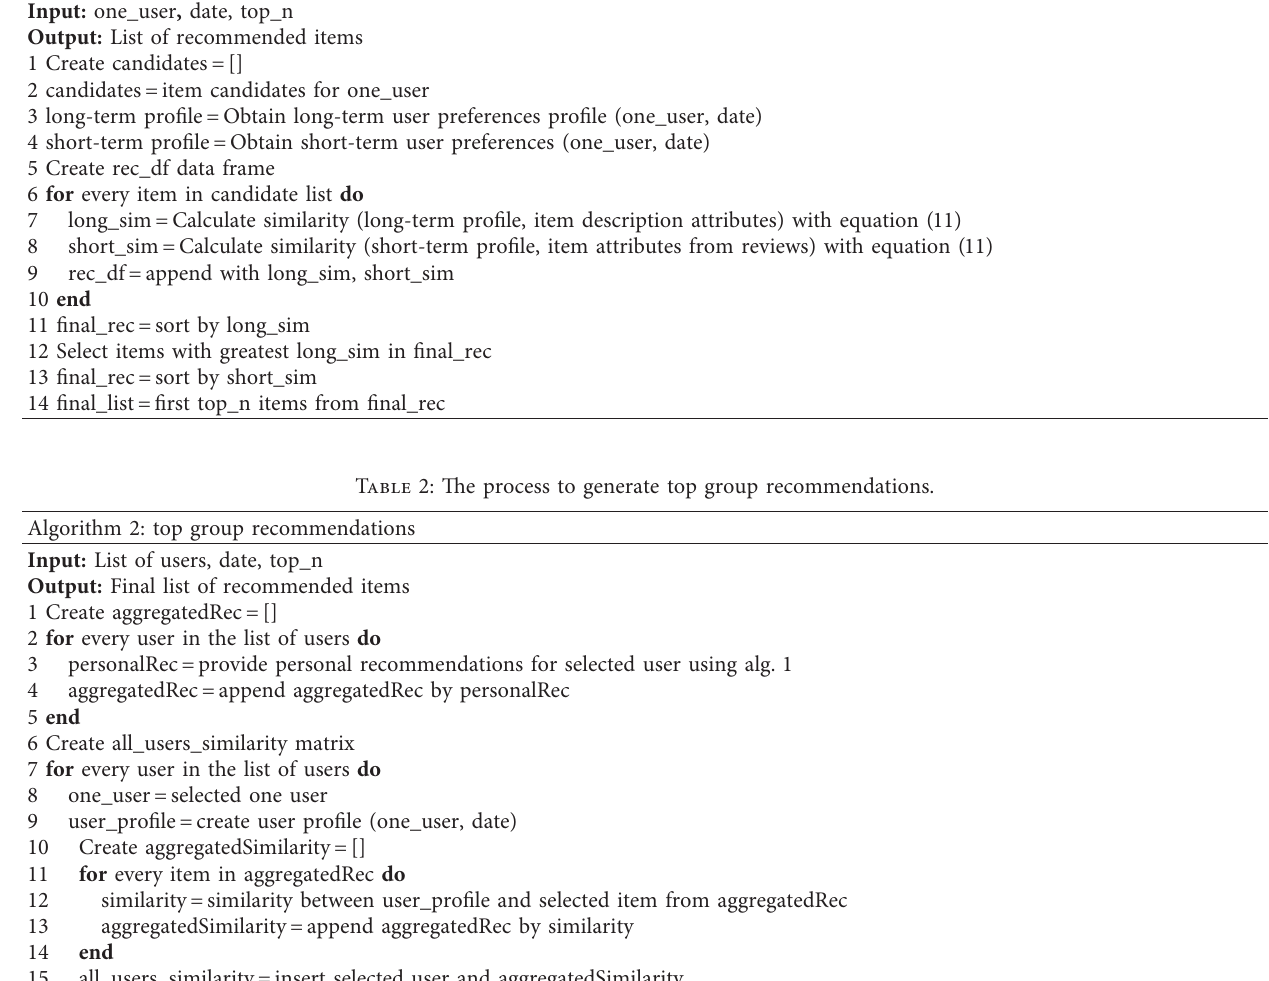
Table 1: The process to generate top personal recommendations. Algorithm 1: top personal recommendations